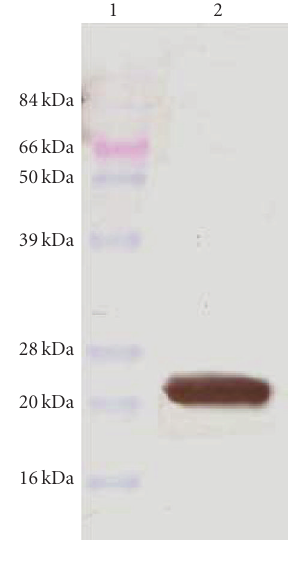
Figure 4: Western blotting analysis of the renatured, purified recombinant protein VEGI-CTT. Ten micrograms of VEGI-CTT were applied into 12% SDS-PAGE, and then electrotransferred to a PVDF membrane. Western blotting analysis was performed using mouse anti-His-Tag monoclonal antibody (Lane 2). The membrane was incubated with the second antibody: HRP-labeled goat antimouse IgG. Lane 1: prestained molecular weight protein markers. Lane 2: fusion protein VEGI-CTT of 22